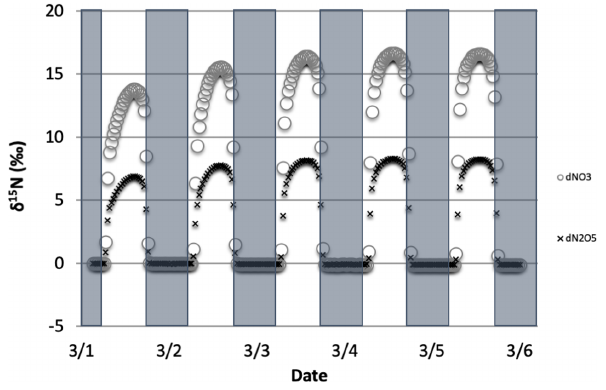
Figure 3. The time evolution of δ 15 N values of NO 3 , and N 2 O 5 caused by PHIFE during NO 3 photolysis.